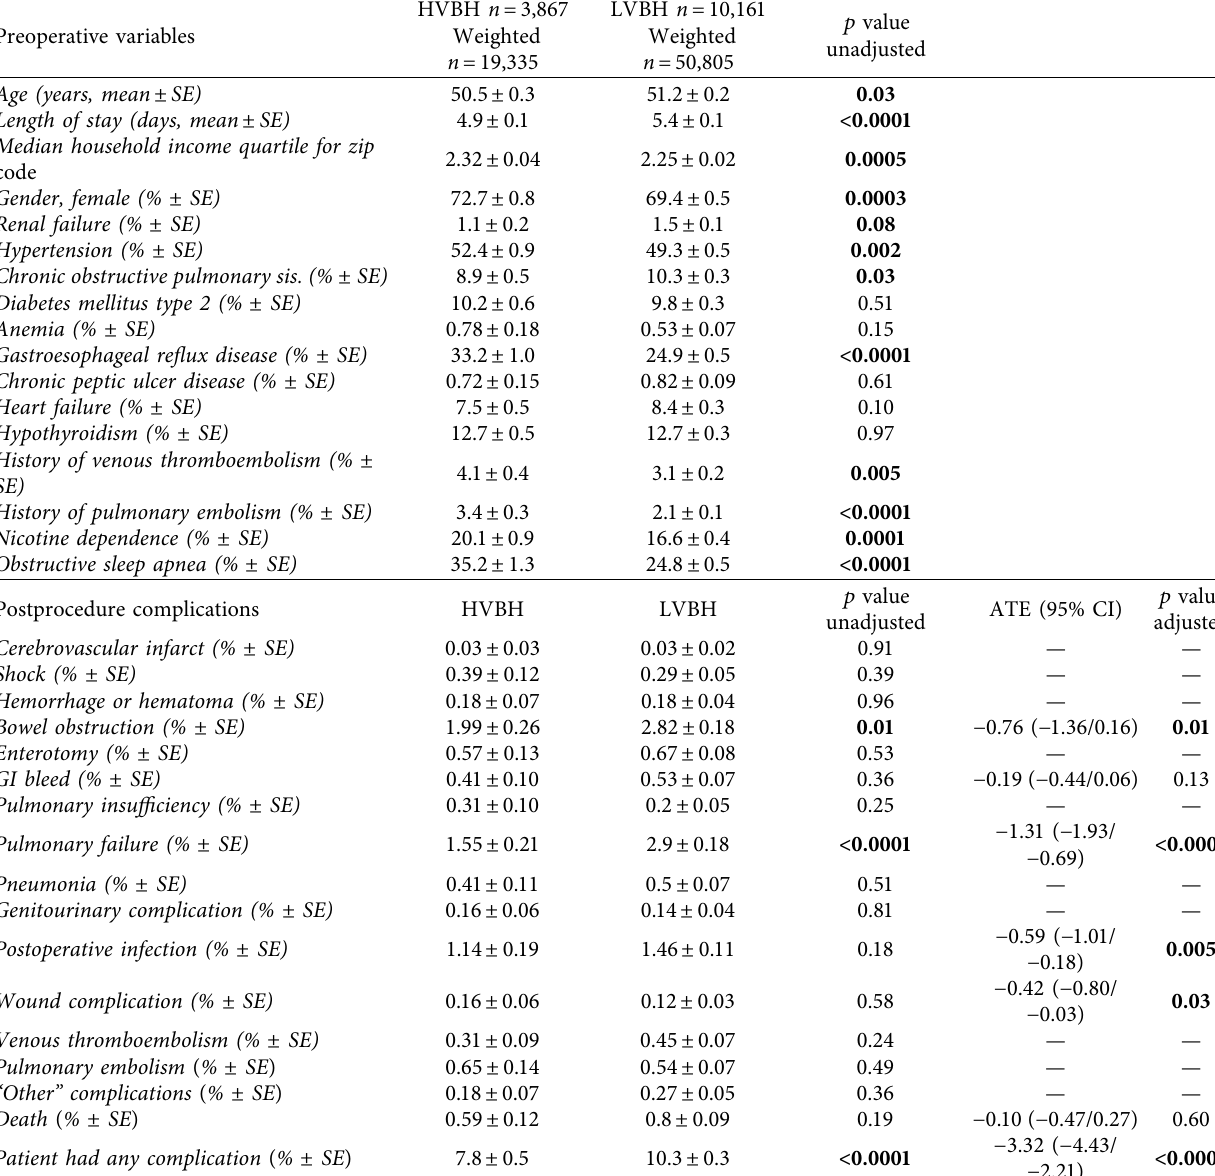
Table 1: Preoperative comorbidities and postoperative complications of patients with morbid obesity undergoing cholecystectomy, appendectomy, or ventral hernia